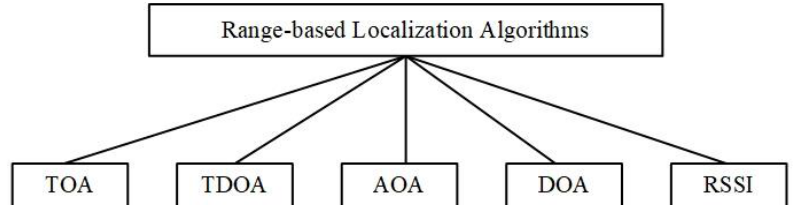
Figure 1. Range-based localization algorithms: time of arrival (TOA), time difference of arrival (TDOA), angle of arrival (AOA), direction of arrival (DOA), and received signal strength indicator (RSSI). To obtain more accurate positioning of the sensor node, most underwater localization schemes estimate the location of sensor nodes by using anchor nodes, detachable elevator transceivers (DET)